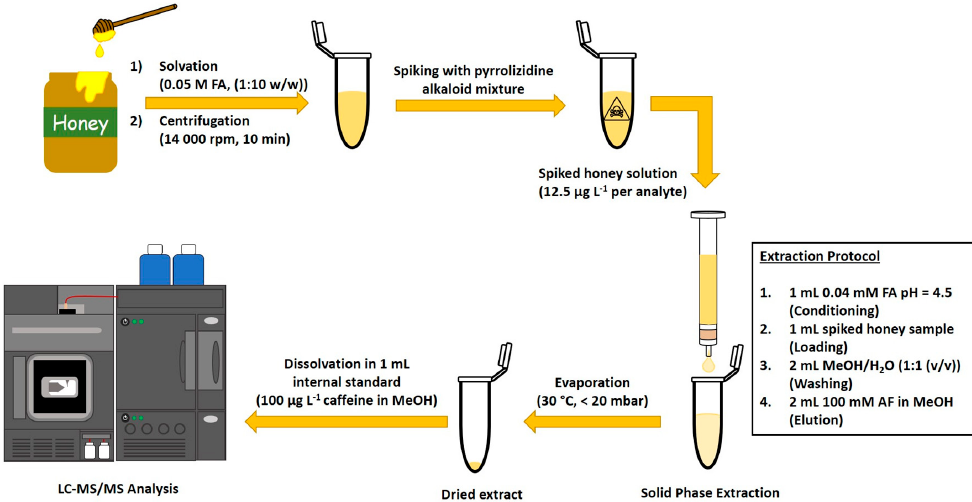
Figure 3. Schematic display of the experimental workflow using organosilyl-sulfonated halloysite nanotubes as material for solid phase extraction of toxic pyrrolizidine alkaloids in honey matrix.